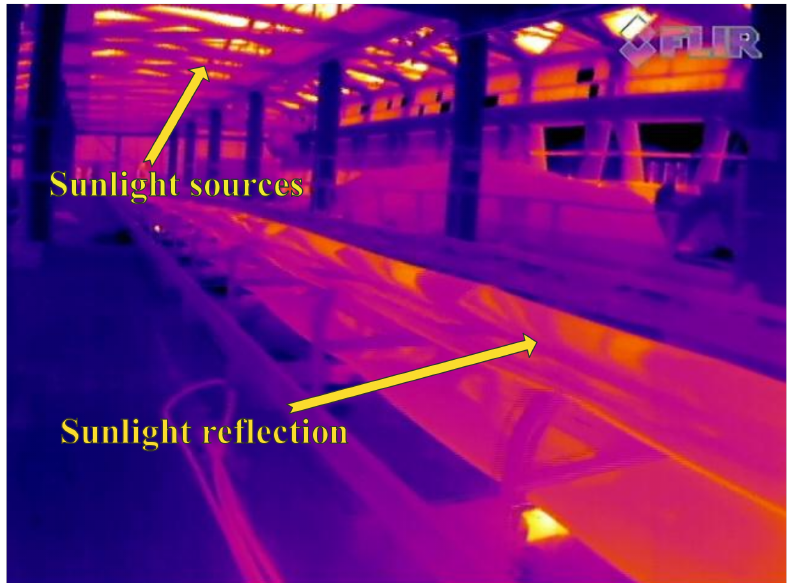
Figure 10. Location of sunlight sources and sun reflections on belt that captured in a raw IR